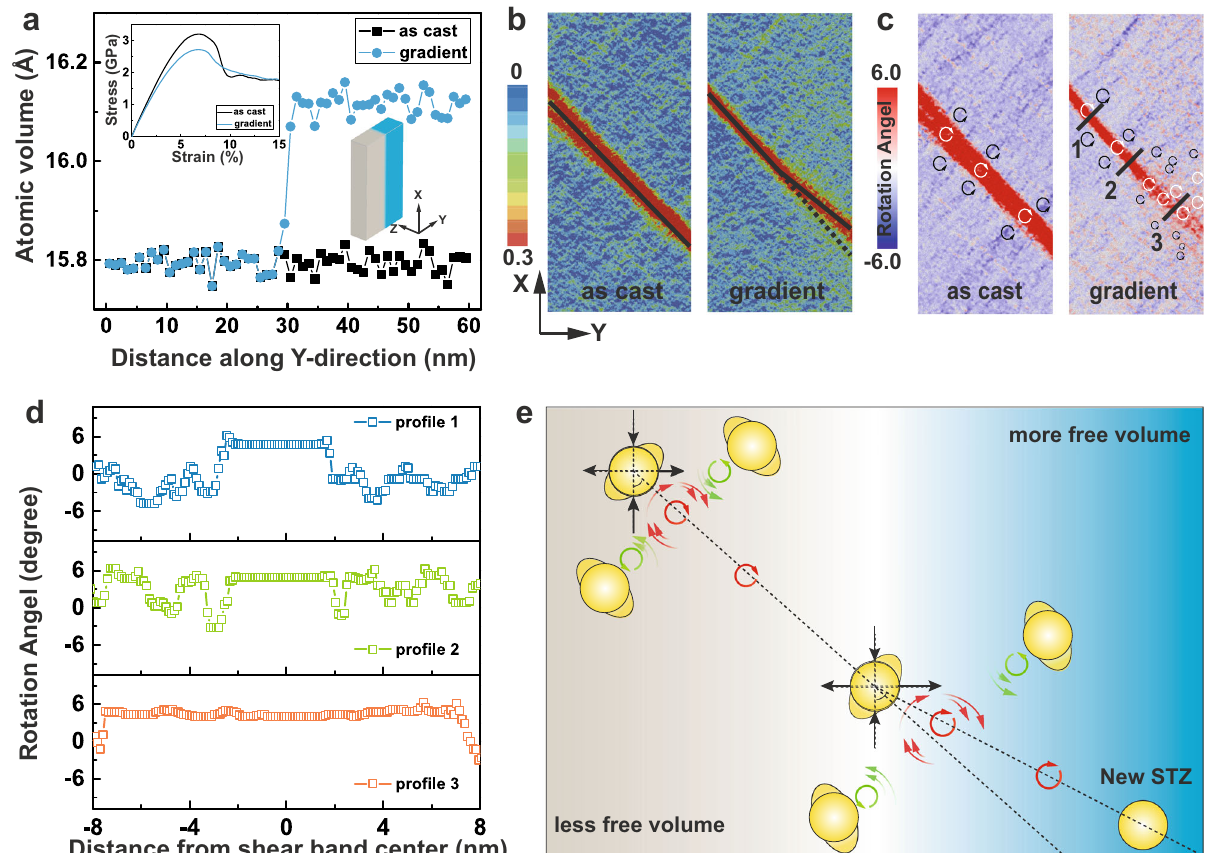
Fig. 5 Investigation of deformation behavior of the GMG by MD simulations. a Atomic free volumes as the functions of the position along the Y -direction in as-cast and GMG samples. Inset shows the representative stress-strain results for the as-cast and GMG samples during compression along the X - direction. b The spatial distribution of atomic Mises strain ( c ) Rotation angle of the as-cast and GMG samples at 9% compression strain. The clockwise and anti-clockwise rotation fi elds were shown by the white and black arrows. d The variations of the rotation angle along lines 1 – 3 (coloured in black) in ( c ). e Schematic illustration of the STZ percolation mechanism in GMG. The clockwise and anti-clockwise rotation strain fi elds were shown by the red and green